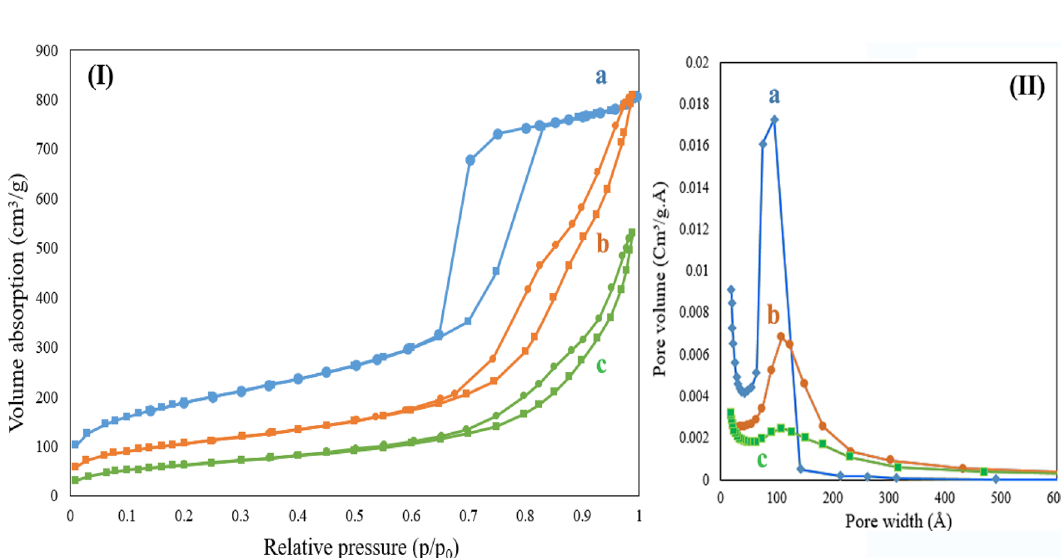
Figure 9. ( I ) N 2 adsorption–desorption isotherms and ( II ) the pore size distribution curve of ( a ) SBA-15, ( b )